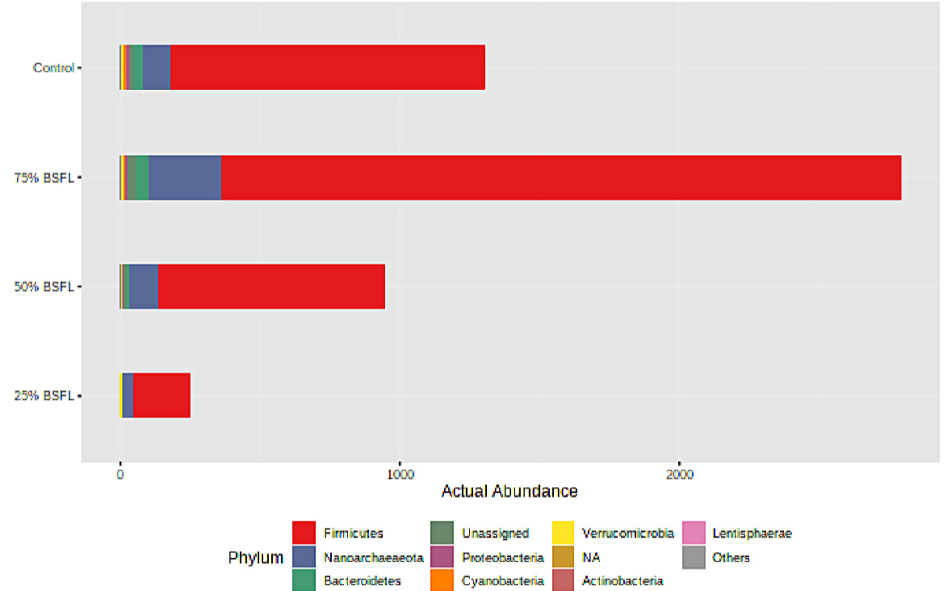
Figure 2. Cumulative relative abundance of the predominant phyla groups observed across all the four dietary treatments.